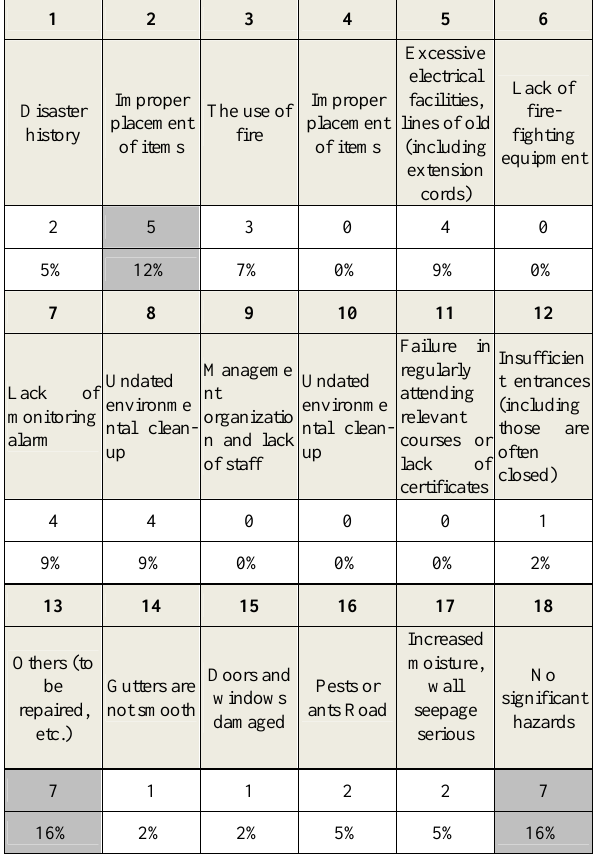
Table 3. 18 hazard indicators statistical chart for